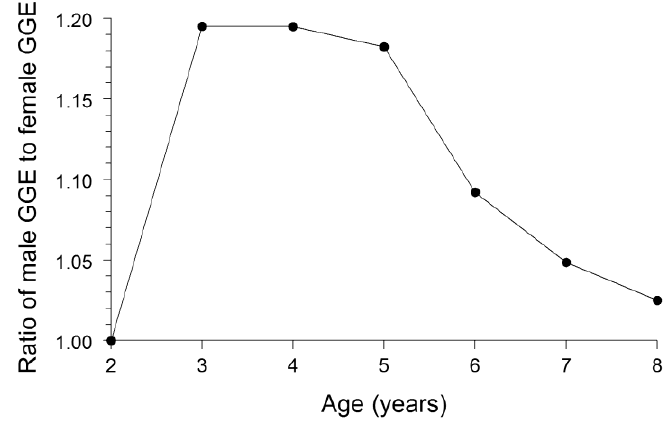
Figure 4. Ratio of GGE for males to GGE for females as a function of bluegill age.